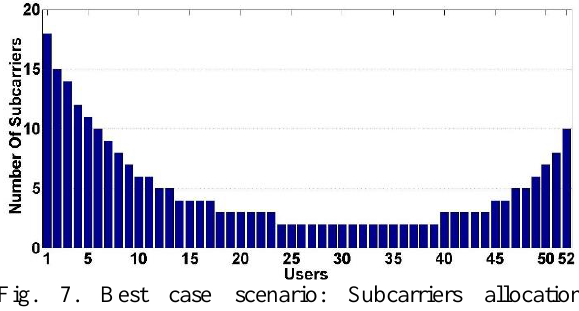
Fig. 7. Best case scenario: Subcarriers allocation